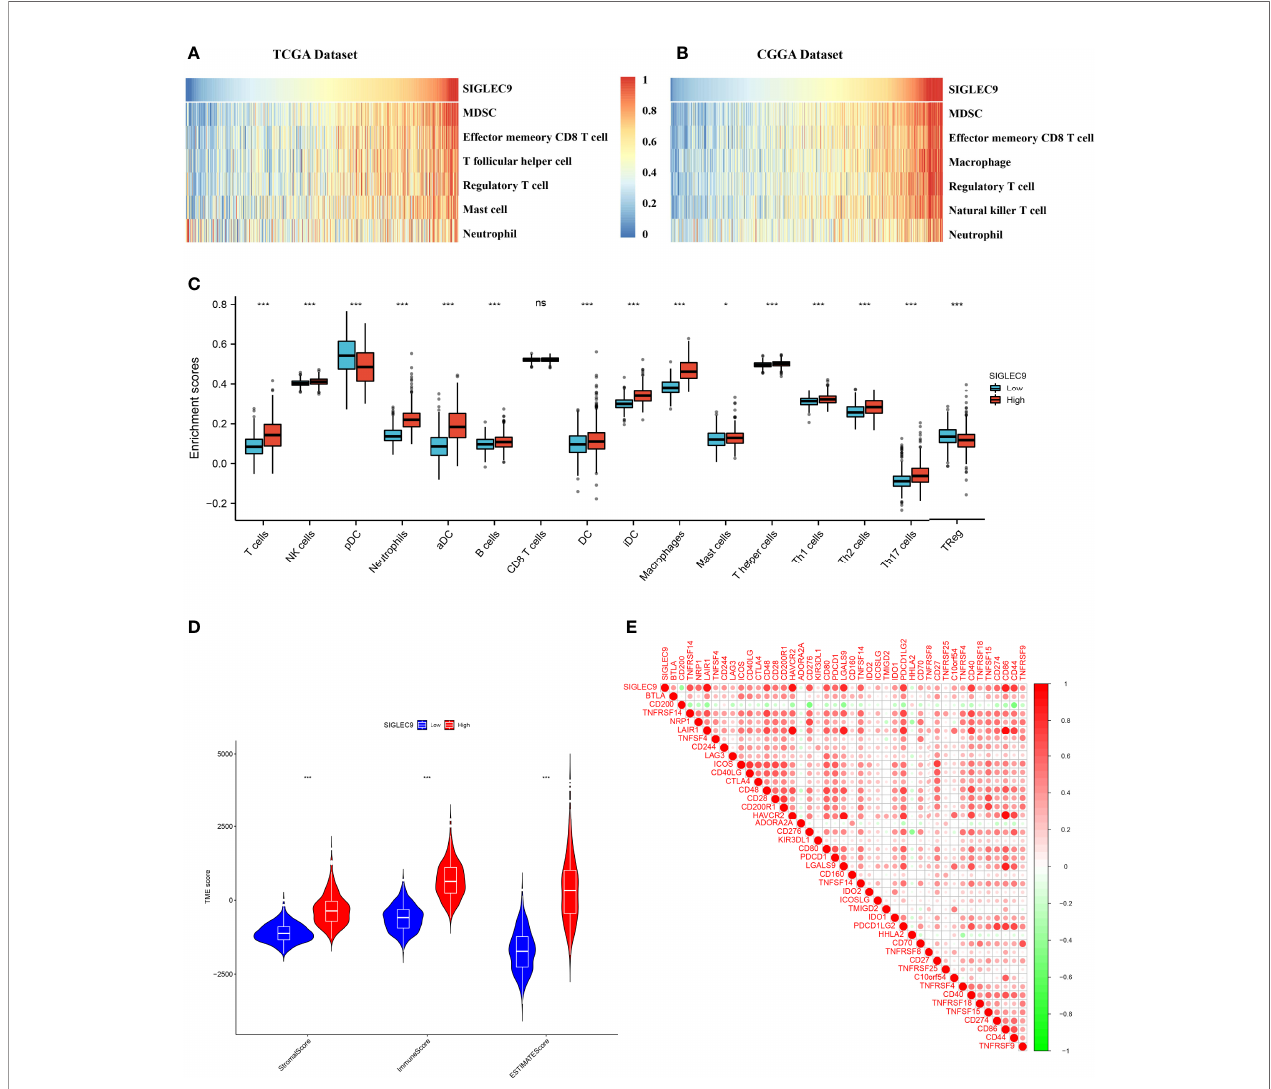
FIGURE 4 | Relationship between SIGLEC9 expression and immune microenvironment. (A) In glioma patients with The Cancer Genome Atlas (TCGA) database, SIGLEC9 expression was positively correlated with immune cell in fi ltration, including myeloid-derived suppressor cells (MDSCs), effector memory CD8 T cells, T follicular helper cells, regulatory T cells, macrophages, etc. (B) In glioma patients with TCGA database, SIGLEC9 expression was positively correlated with MDSCs, effector memory CD8 T cells, macrophages, regulatory T cells, natural killer T cells, neutrophils, etc. (C) Differences in immune cell in fi ltration between the high and the low expression of SIGLEC9, respectively. (D) Relationship between SIGLEC9 expression and immune microenvironment score. (E) Relationship between SIGLEC9 expression and immune checkpoints. ns, p ≥ 0.05; *, p< 0.05; ***,